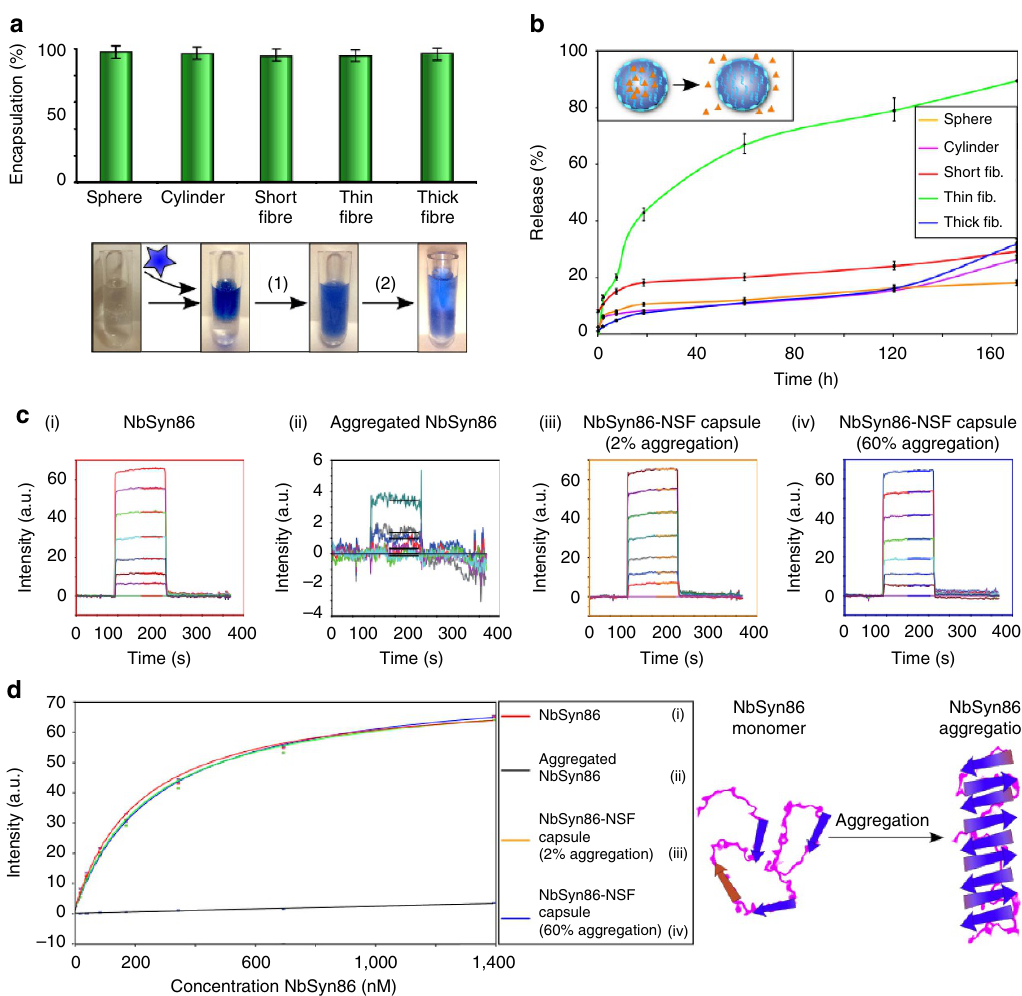
Figure 5 | Antibodies stabilization by encapsulation. ( a ) Encapsulation efficiency studies for the C4scFv single chain Fv domain in spheres, cylinders, short, thin and thick fibres. The indicated error bars are the s.d. of the average of three different repeats, each one measure 10 times. Insert: schematic representation of the encapsulation and release of antibiody domains by NSF micrococoons: step (1) encapsulation, step (2) release. ( b ) Release kinetics for C4scFv from different NSF micrococoon shapes. The indicated error bars are the s.d. of the average of three different repeats, each one measure 10 times. ( c ) Biacore sensorgrams of the binding of NbSyn86 to immobilized a -synuclein: (i) a control sample of monomeric NbSyn86, (ii) NbSyn86 after encapsulation and release treatment in the absence of NSF, (iii) NbSyn86 released from gelled NSF micrococoons (which contain ca. 2% of aggregated NSF), (iv) NbSyn86 released from gelled micrococoons which contain ca. 60% of aggregated NSF. ( d ) Graph of the equilibrium binding values for the different released NbSyn86 samples (as shown in c ) versus the initial (pre-encapsulation) concentration of NbSyn86. The data were fitted to a 1:1 bimolecular binding model to estimate the affinity constant of NbSyn86 for a -synuclein, and were also used to estimate the loss of activity between samples. The indicated error bars are the s.d. of the average of three different repeats, each one measure five